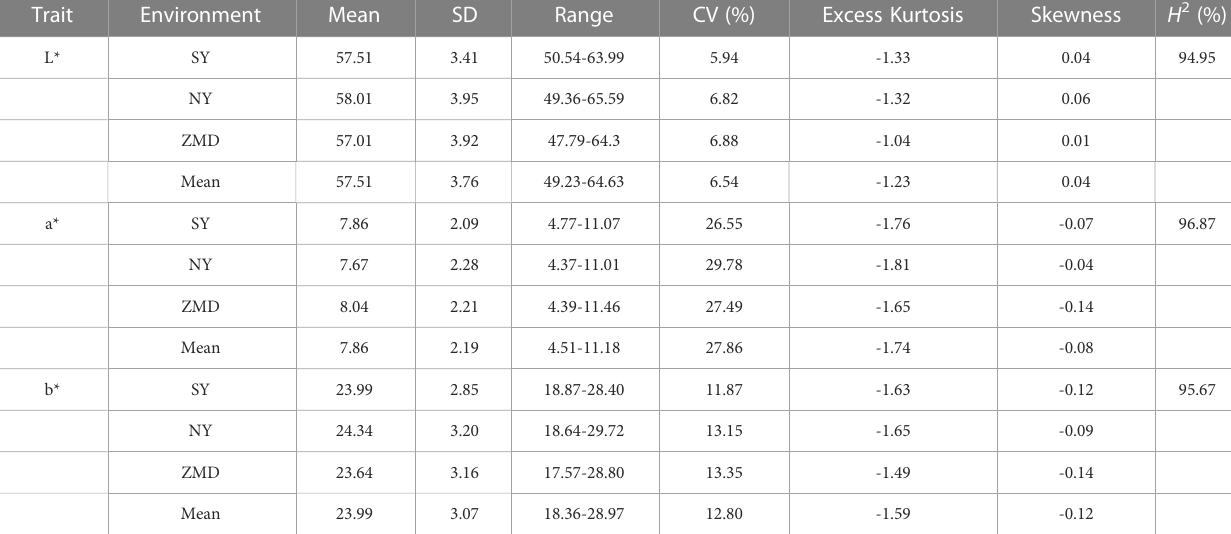
TABLE 1 Descriptive statistics and broad-sense heritability ( H 2 ) for three seed coat color related traits of RILs.